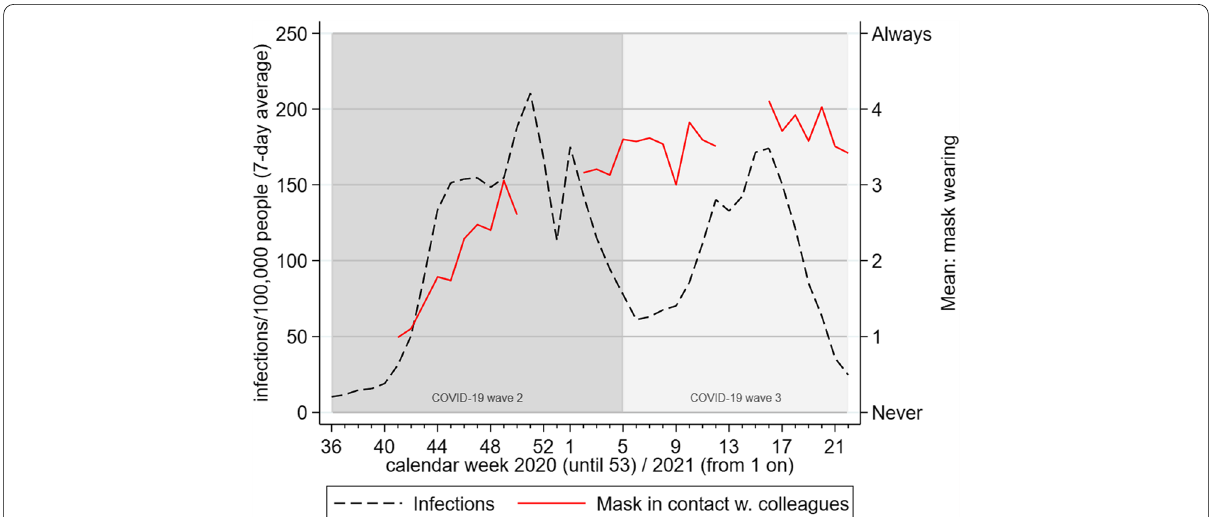
Fig. 2 Weekly COVID-19 infection rates and prevalence of mask-wearing of pedagogical staff in interactions with colleagues. Legend: as reported by directors in the respective ECEC centers, CKS-Survey 2020